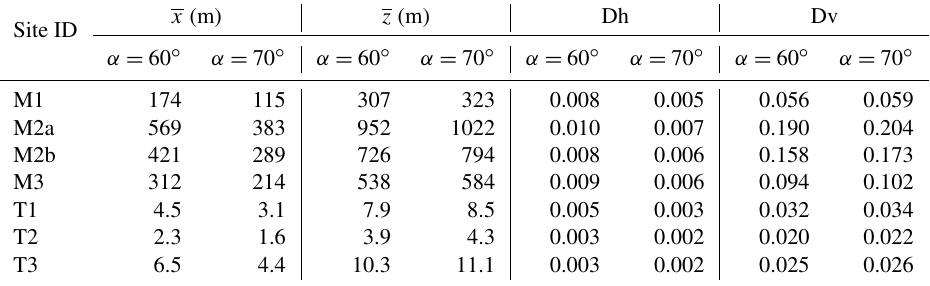
Table 2. Mean horizontal and vertical displacements, in metres and scaled, at the six study sites. M2a assumes that the central valley in Site M2 is of purely DSGSD origin, whereas M2b assumes that the central valley has a purely glacial